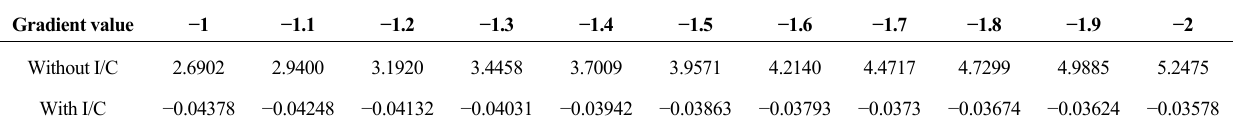
Table 4. Supplier surplus deviation index with respect to gradients of the demand